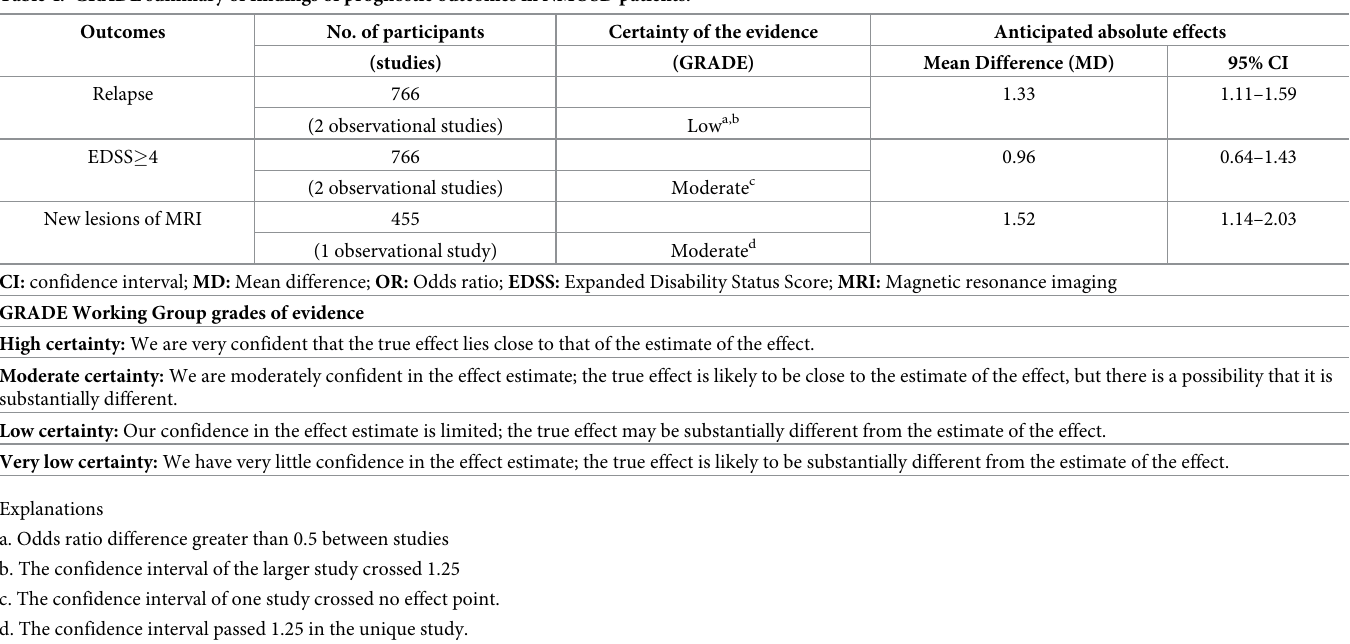
Table 4. GRADE summary of findings of prognostic outcomes in NMOSD